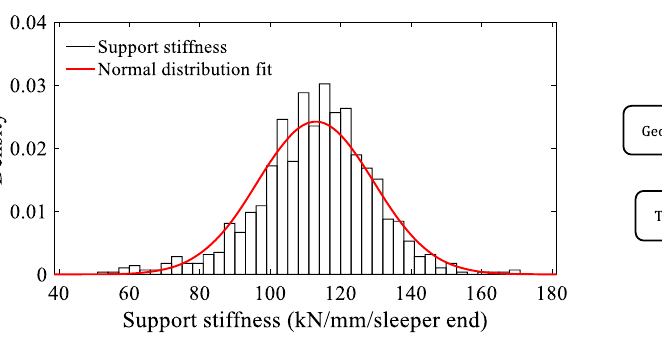
Fig. 9 Support stiffness distribution